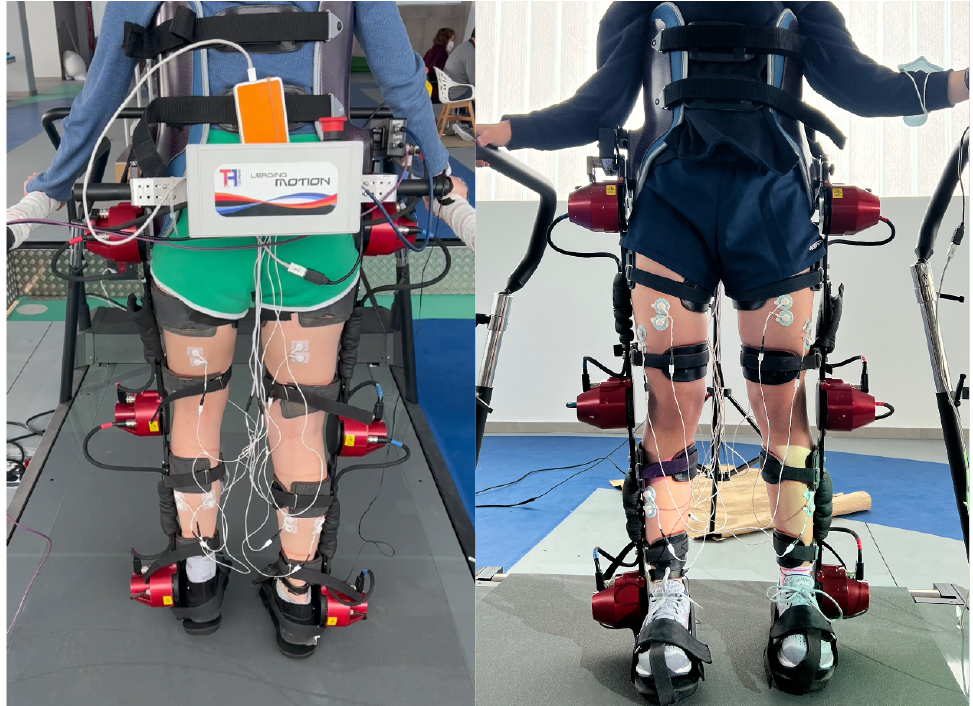
Figure 5. Pictures of two different subjects while they walked with Exo-H3. Most of the experimental setup is represented in the two